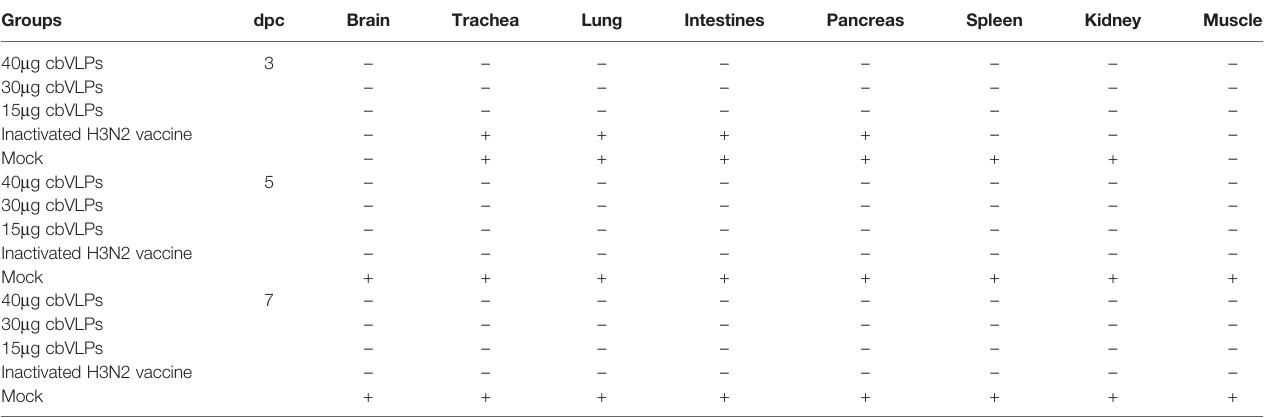
TABLE 4 | In vivo distribution of H3N2 AIV in those immunized chickens on 3, 5, and 7 days post challenge.